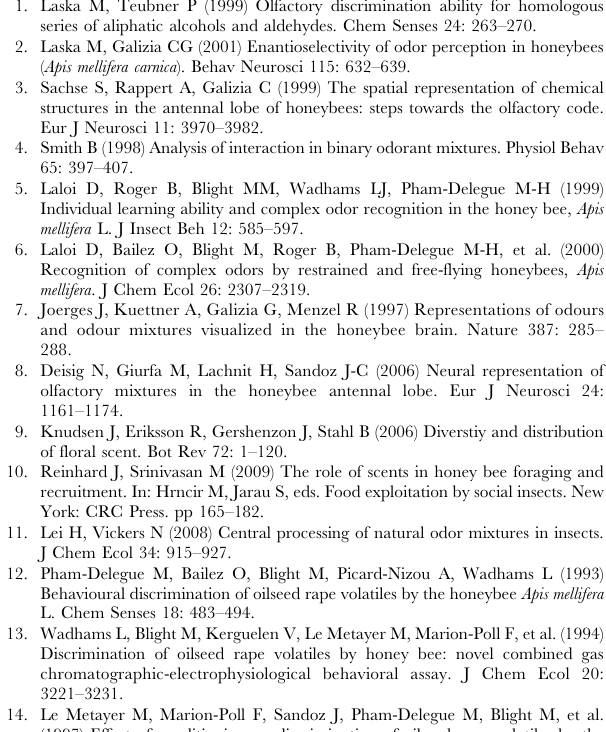
Table S3 Discrimination efficiency of Limonene, Myrcene,